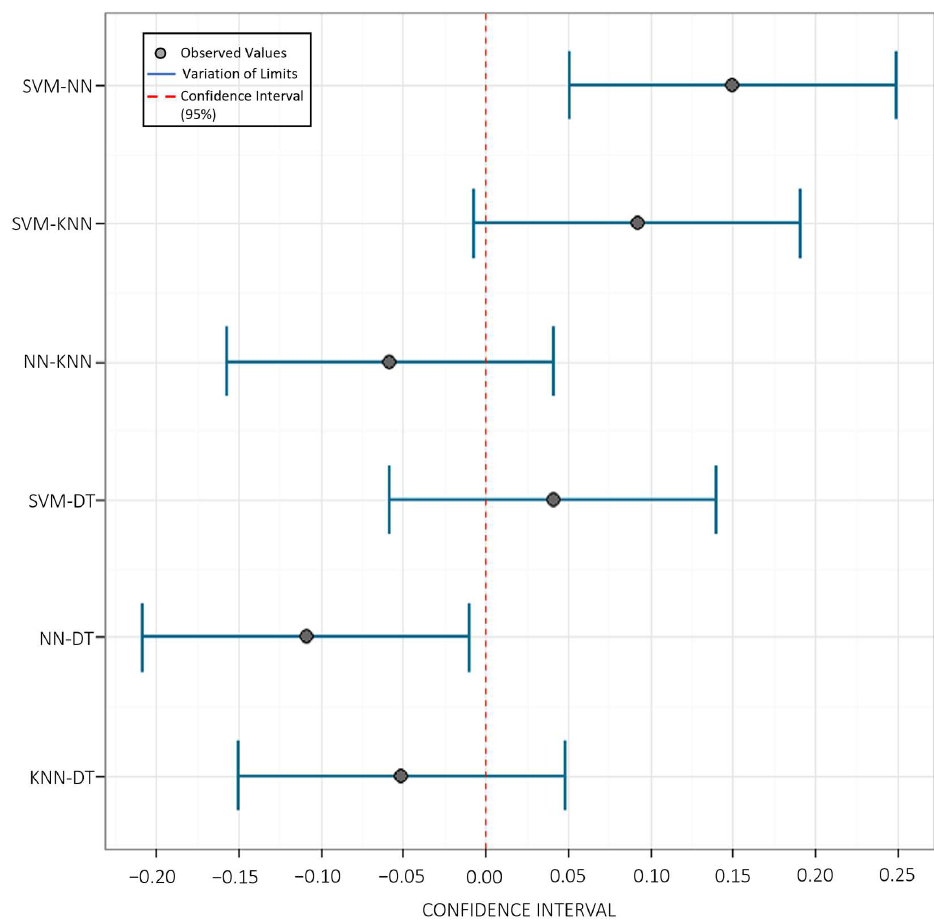
Figure 14. Differences between classification algorithms (DT, KNN, SVM and NN) based on confi- dence interval (95%). dence interval